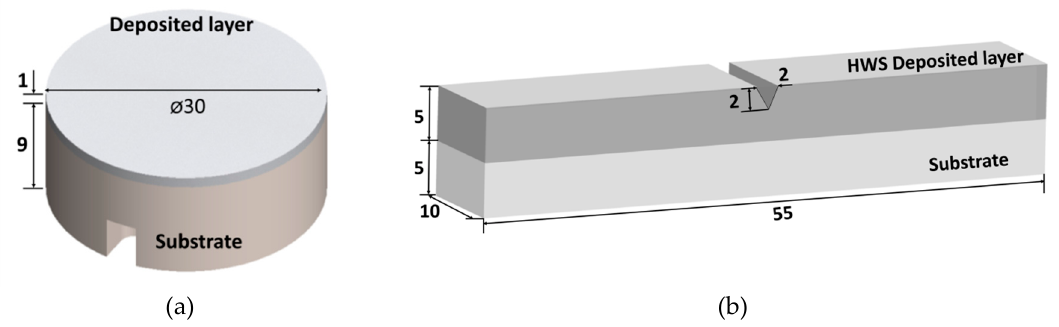
Figure 3. Schematics of the specimens for the ( a ) wear test and ( b ) Charpy impact test (unit: